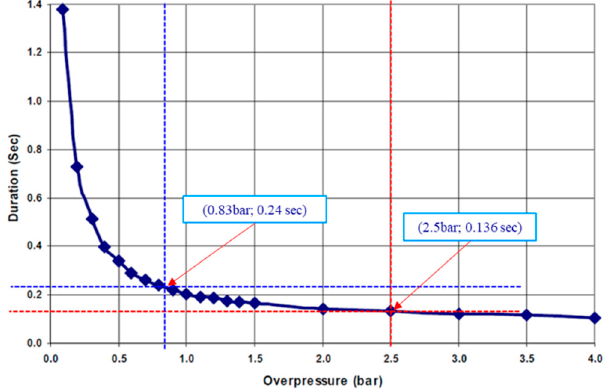
Figure 9. Pressure durations relationship based on API RP 2FB [24].